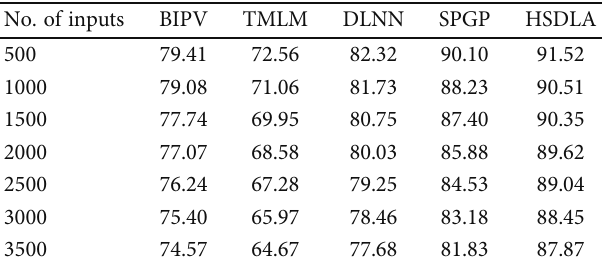
Table 5: Reservation of high